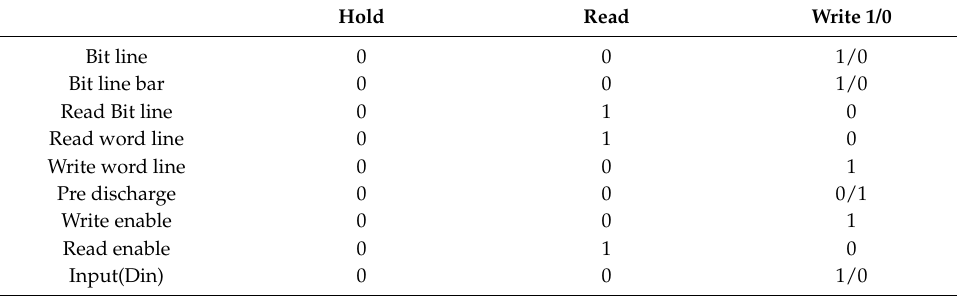
Table 3. Status of control signals for proposed PLNA 8T